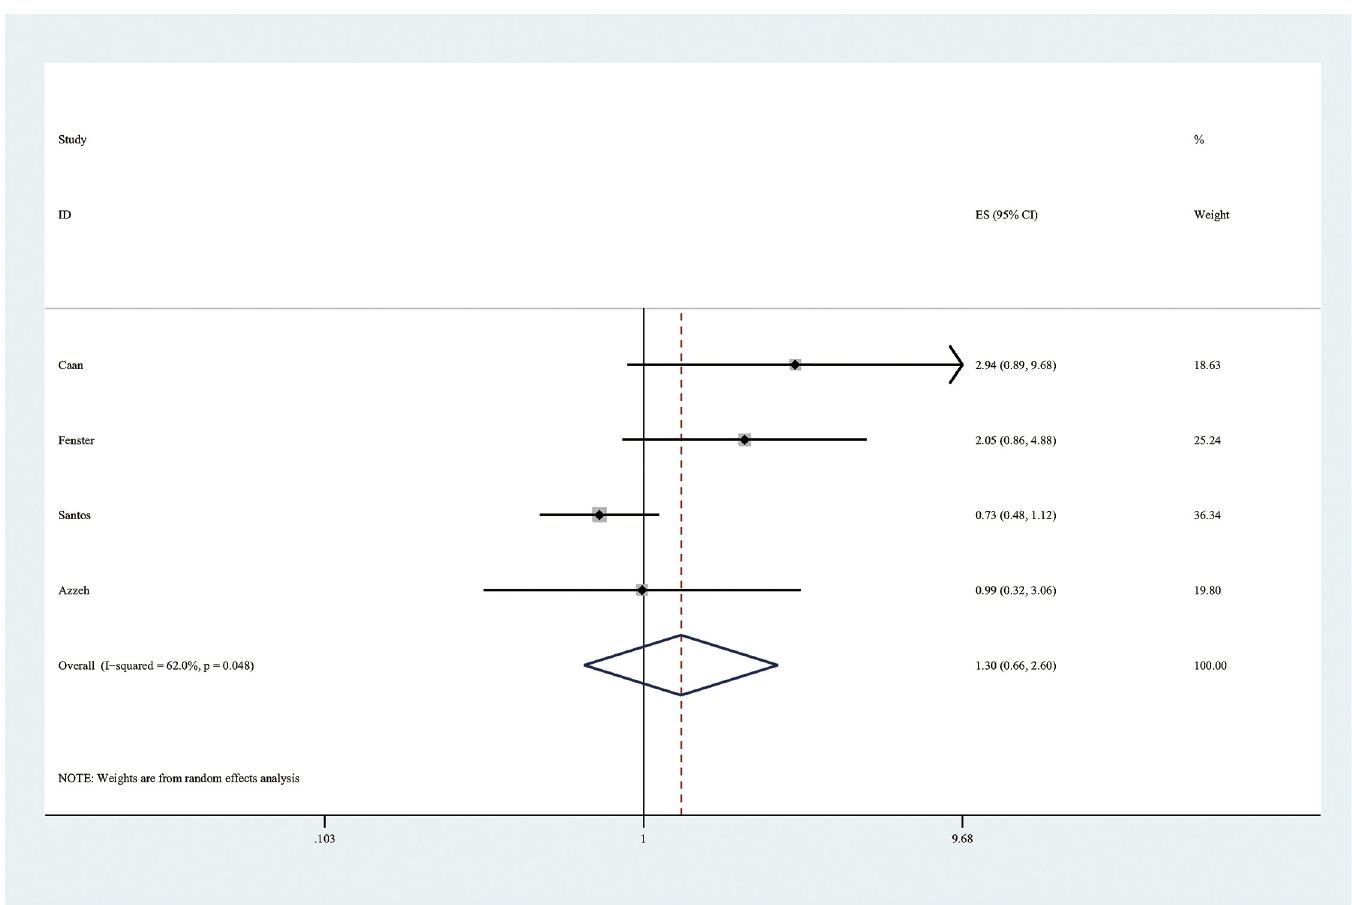
Fig 4. Forest plot of meta-analysis by using random effects model for the effect of maternal caffeine intake during pregnancy on the risk of low birth weight (comparing highest versus lowest levels) among case-control studies.